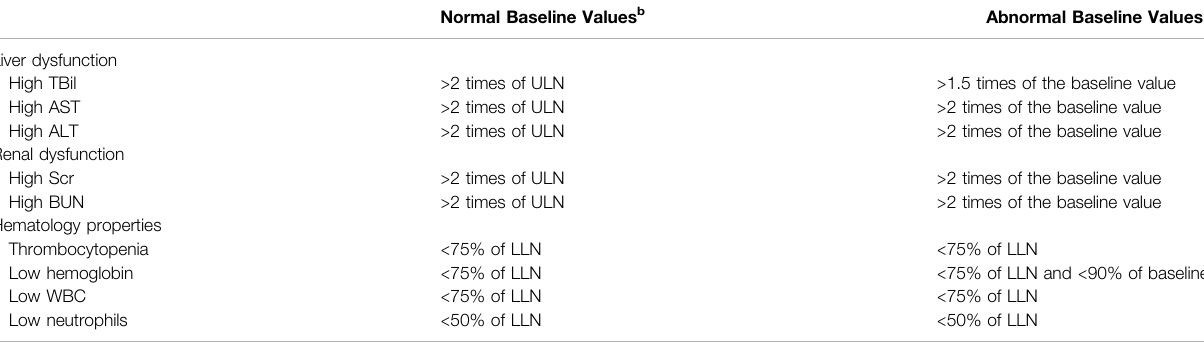
TABLE 1 | The de fi nition of laboratory adverse events a .